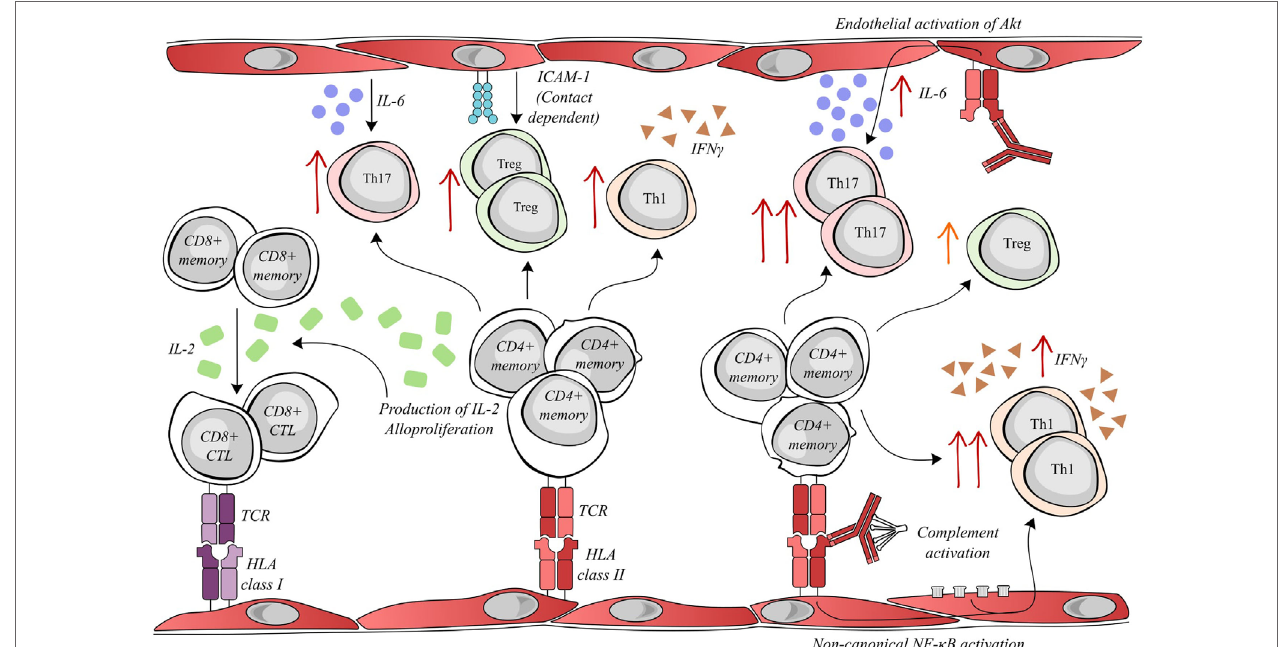
FiGURe 1 | Activated endothelial cells modulate allogenic T lymphocyte activity. Allogenic endothelial cells expressing HLA class II molecules are capable of inducing the secretion of IL-2 and alloproliferation by CD4 + memory lymphocytes. The T helper cell production of IL-2 facilitates the differentiation of memory CD8 + T cells into cytotoxic lymphocytes (CTLs), which can mediate rejection by targeting donor HLA class I molecules. Meanwhile, alloproliferation in CD4 + lymphocytes is associated with the selective expansion of pro-inflammatory Th17 (endothelial IL-6-dependent), anti-inflammatory Treg (endothelial ICAM-1 dependent) and pro-inflammatory Th1 subsets. Interestingly, donor-specific antibodies (DSAs) binding to HLA class II molecules alter endothelial cell immunogenicity. DSA binding can activate the Akt/PI3K-signaling pathway, consequently increasing endothelial IL-6 secretion and increasing the expansion of the pro-inflammatory Th17 subset. In addition, the amplification of the Treg population was decreased after DSA binding. Both the binding of DSA and the sub-lytic activation of the complement cascade can synergize to activate non-canonical NF- κ B signaling in endothelial cells, ultimately resulting in an increased expansion of the Th1 subset and a greater secretion of IFN γ